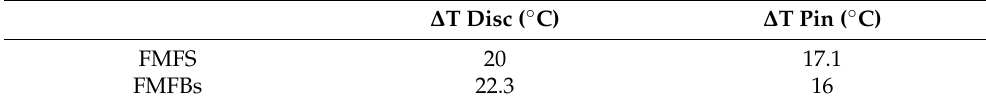
Table 2. Pin and disc temporal mass temperature variation for FMFS and